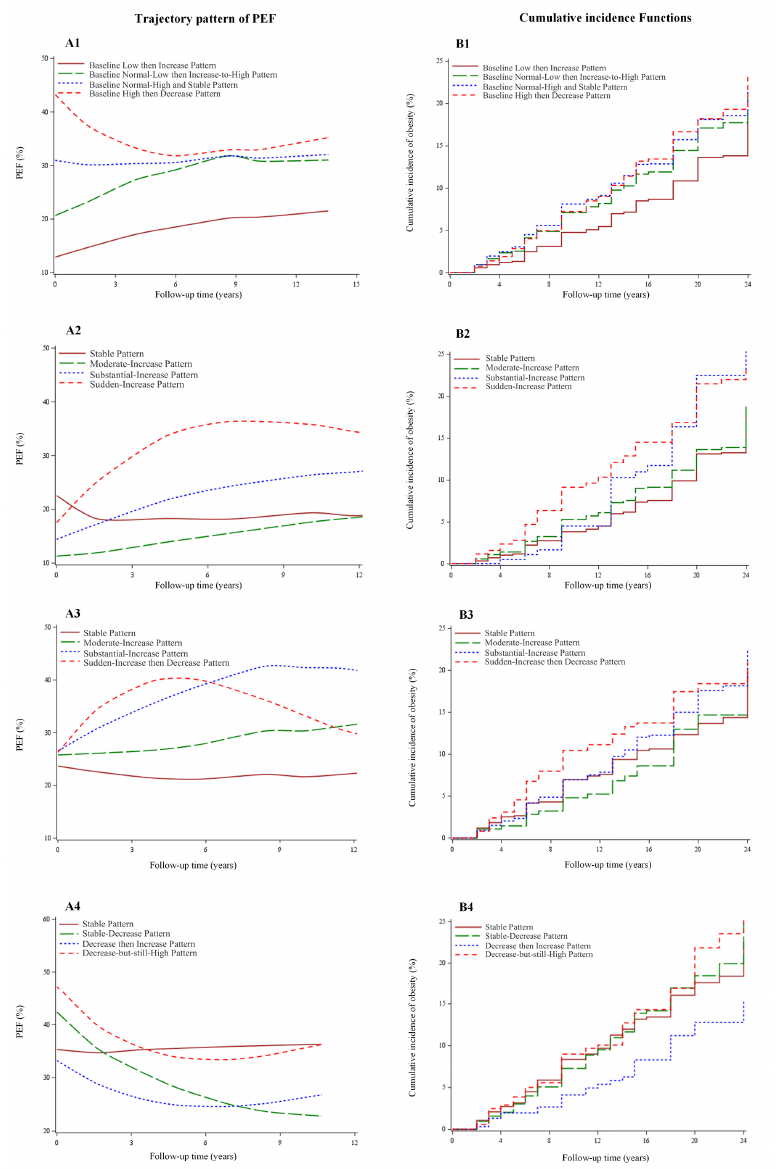
Figure 2. Change trajectories of the percentage of energy from fat and the cumulative